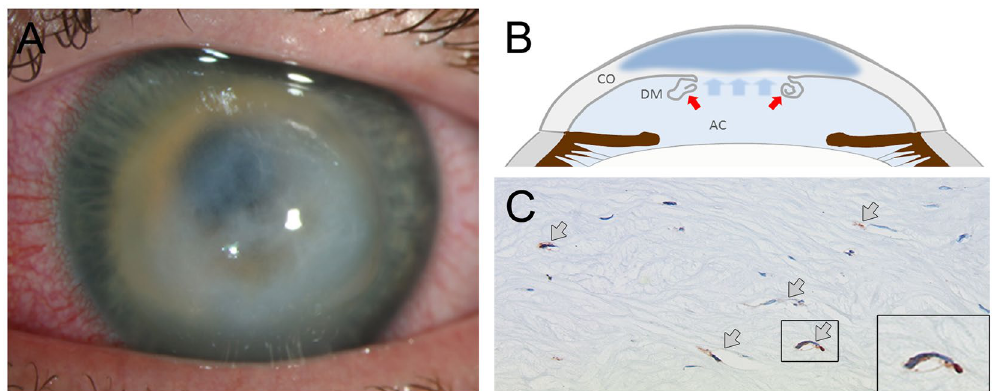
Figure 3. Evidence of isolated corneal lymphangiogenesis in a patient with acute keratoconus. (A) Representative clinical image of a patient with keratoconus and acute corneal edema due to spontaneous rupture of the (Descemet´s) basement membrane and subsequent fluid accumulation (acute keratoconus). (B) Schematic drawing depicting acute keratokonus: due to rupture of the Descemet´s membrane (DM; red arrows), fluid from the anterior chamber (AC) rapidly accumulates in the cornea (CO), leading to loss of corneal transparency. (C) Histological analysis of the cornea from a patient with acute keratoconus obtained after corneal transplantation shows LYVE-1 positive lymphatic vessels in the corneal stroma (arrows) without evidence for blood